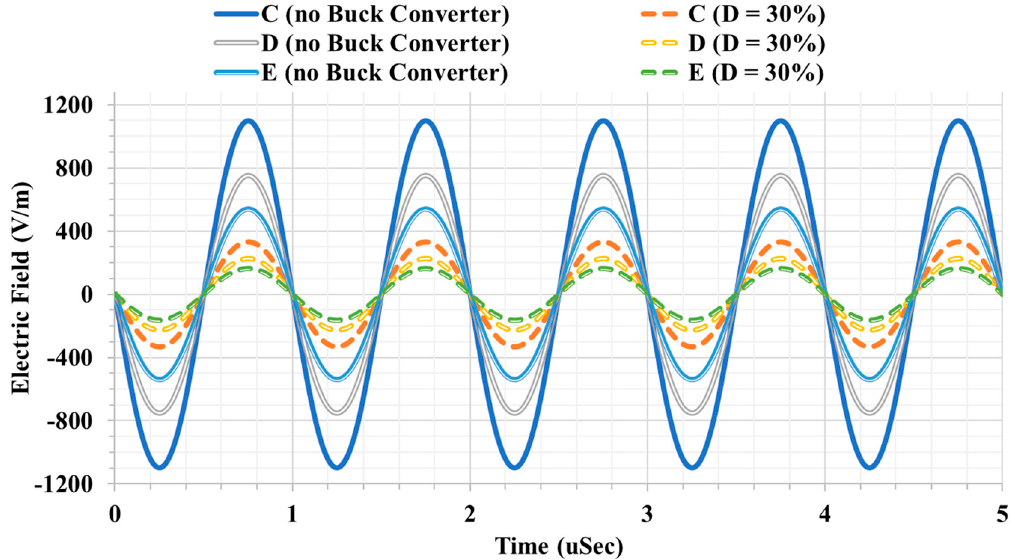
Figure 12. Simulated electric field at measurement points C, D, and E above the center of Tx1 and Rx1.